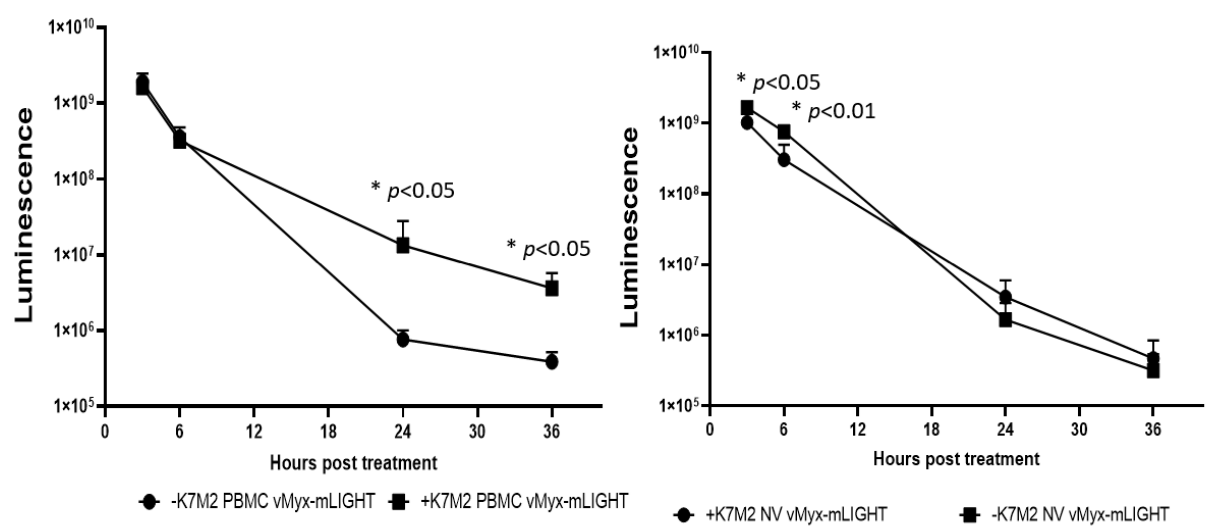
Figure 3. vMyx-mLIGHT systemically delivered via PBMC carrier cells or as naked virus produced increased total transgene expression in whole-body images of mice bearing K7M2-luc tumors. ( A ) Luminescence images of K7M2-luc tumor-bearing animals systemically infused with: ( i ) vMyx-mLight + PBMCs, ( ii ) vMyx-mLIGHT intravenously delivered as naked virus and ( v ) vMyx-Fluc + PBMCs; and non-tumor bearing control animals systemically infused with: ( iii ) vMyx-mLight + PBMCs, ( iv ) vMyx-mLIGHT delivered intravenously as naked virus. ( B ) Line graphs showing average luminescence, comparing different viral treatments, delivery methods, and tumor statuses. Error bars are mean ± SD. Some control animals treated with reporter vMyx-Fluc were previously shown, in part, in Christie et al. 2021 [13].